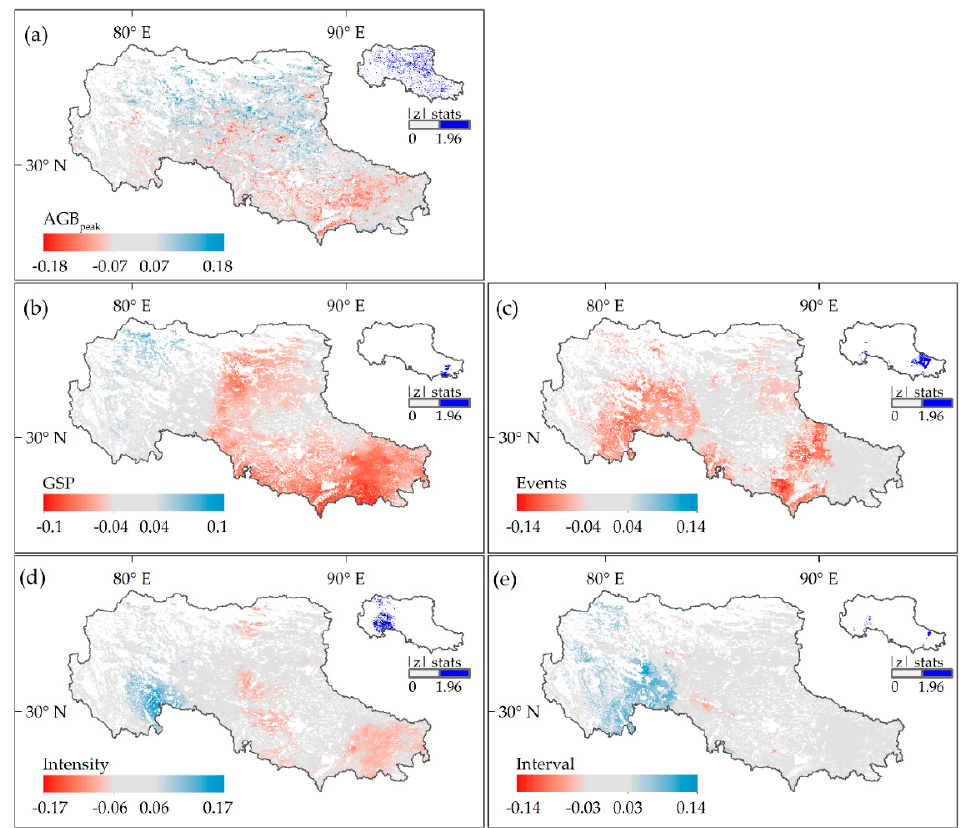
Figure 8. Spatial pattern of trends (Theil–Sen slopes) in ( a ) peak aboveground biomass (AGB peak , g m − 2 yr − 1 ), ( b ) growing season precipitation (GSP, mm yr − 1 ), ( c ) number of precipitation events (Events, n yr − 1 ), ( d ) mean intensity of precipitation events (Intensity, mm yr − 1 ), and ( e ) time interval between precipitation events (Intervals, n × 8-day yr − 1 ) of the northern Tibetan Plateau. The map inserted at the top left corner of each panel indicates the Mann–Kendall test for significance at the α = 0.05 level, where |z| − stats ≥ 1.96 indicate significant trends (in blue) at the pixel scale.